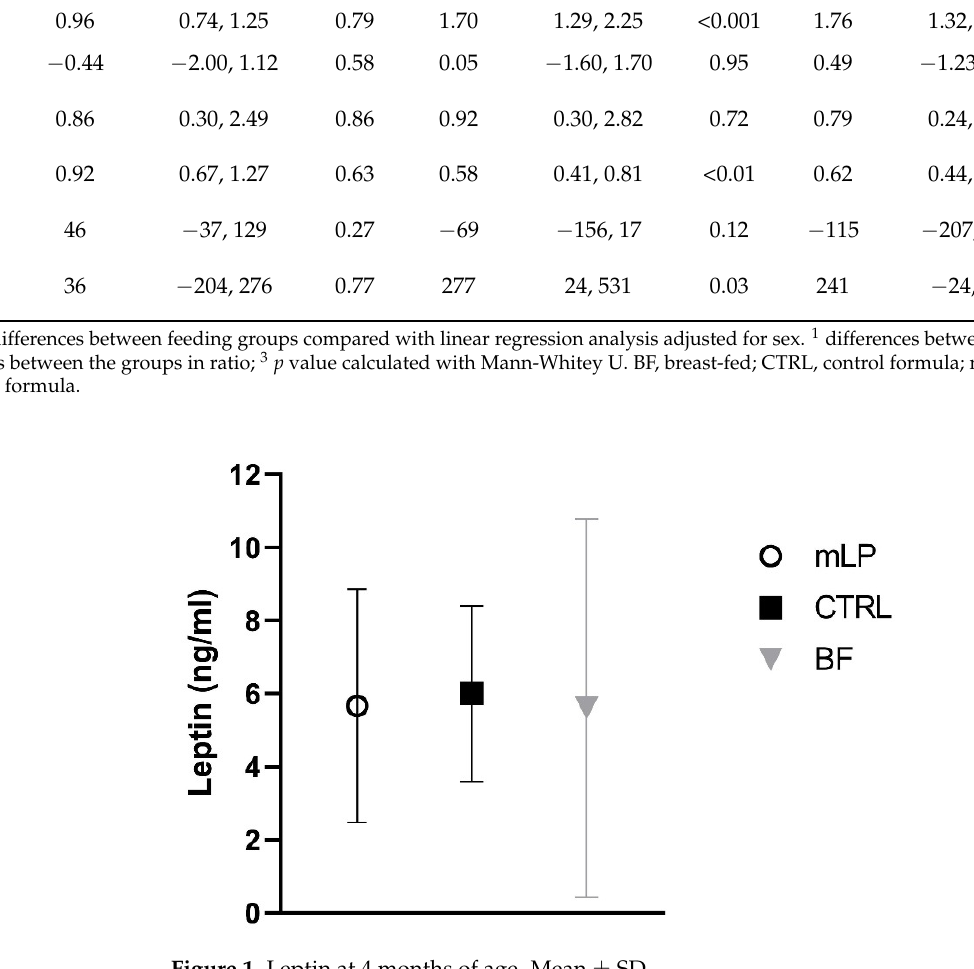
Figure 2. HOMA-IR at 4 months of age. Median (IQR), * p < 0.001. 4.2. Associations between Metabolic and Hormonal Markers and Anthropometric Parameters at 4 Months of Age At the age of 4 months, we found a positive association between leptin and all an- thropometric outcomes, including body composition. We further found that IGF-BP1 was negatively associated with length. IGF-BP2 was negatively associated with weight and fat-free mass while IGF-BP3 was positively associated with weight and fat-free mass (Table 5).